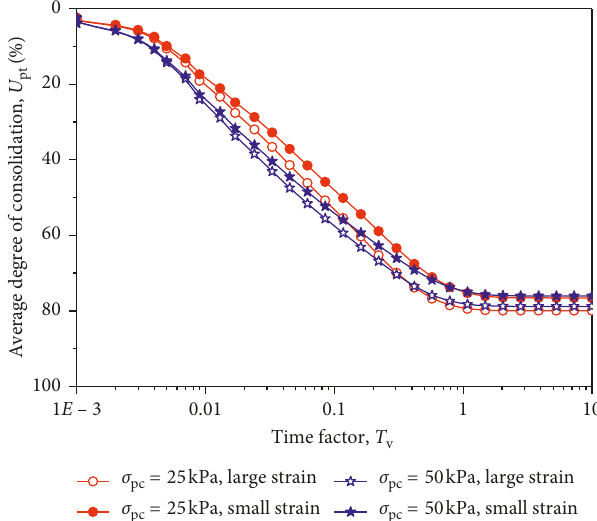
Figure 10: Influence of geometric suppositions on U different i 0 .